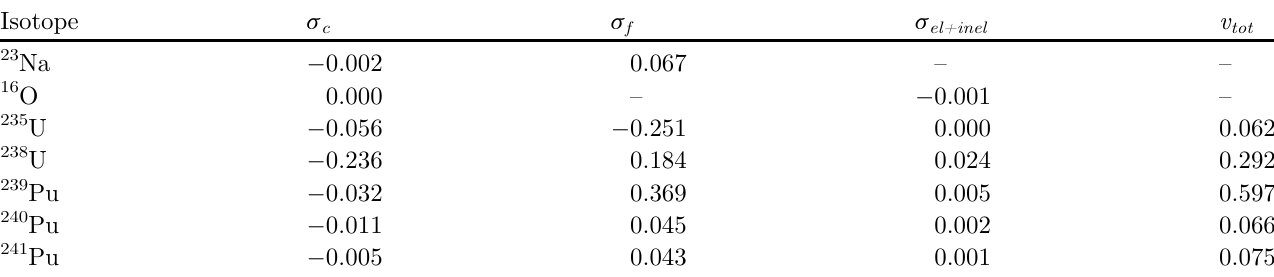
Table 6. Sensitivity coef fi cients (in %/%) on D r 235 U for the ERMINE thermal-spectrum experiment. Isotope